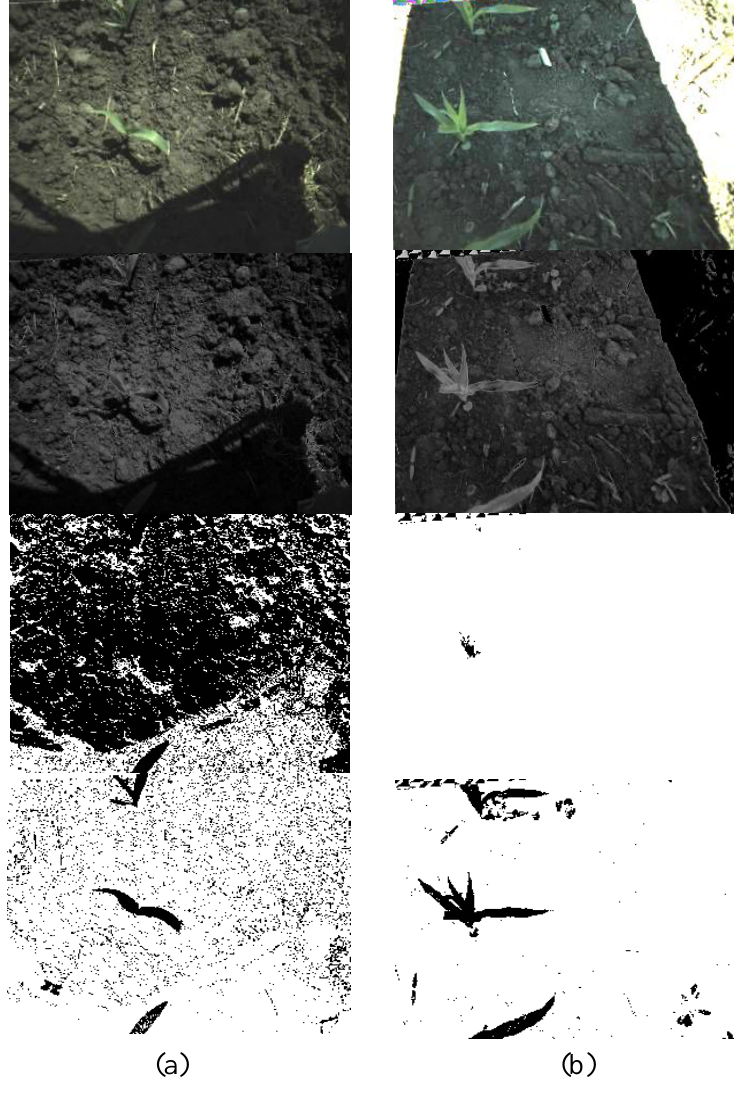
Figure 3. Changes of image segmentation results by adjusting the threshold values: two conditions of initial image segmentation results are presented. ( a ) Changes of image segmentation results by adjusting threshold values when the initial segmented pixel rate was higher than the upper limit (Images shown are original RGB (top), NEG, 1st and 2nd (bottom) threshold adjustment images). ( b ) Changes of image segmentation results by adjusting threshold value when the initial segmented pixel rate was smaller than the lower limit (Images shown are original RGB (top), NEG, 4th and 9th (bottom) threshold adjustment